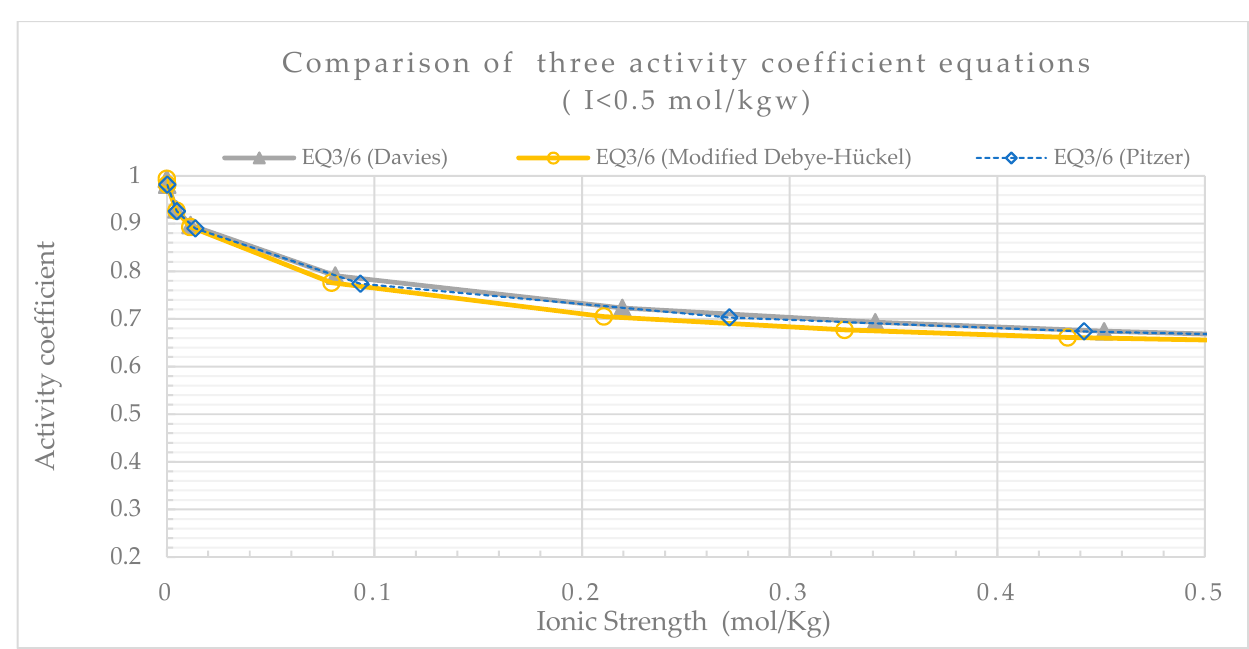
Figure 12. Comparison of the activity coefficients calculated using the Davies and modified Debye–Hückel equations through PHREEQC and EQ3/6.